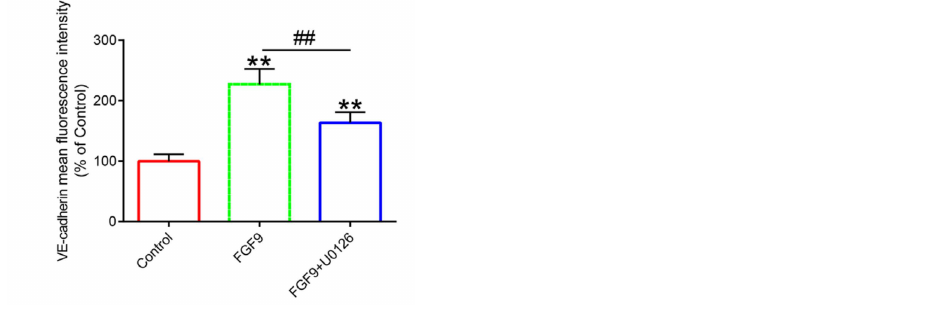
Figure 4. FGF9 promoted flap angiogenesis. ( A ) Immunofluorescence staining of VE cadherin protein in control, FGF9 treatment, and FGF9+U0126 treatment groups. DAPI (blue) was used to labeled nuclei. Magnification = 80 × ; scale bar = 25 µ m. ( B ) VE cadherin fluorescence intensity statistics. ** represents p < 0.01 versus the control group, and ## represents p < 0.01 comparing the FGF9 group with the FGF9+U0126 group, indicating statistical significance. Data are the mean values ± SD, n = 6.